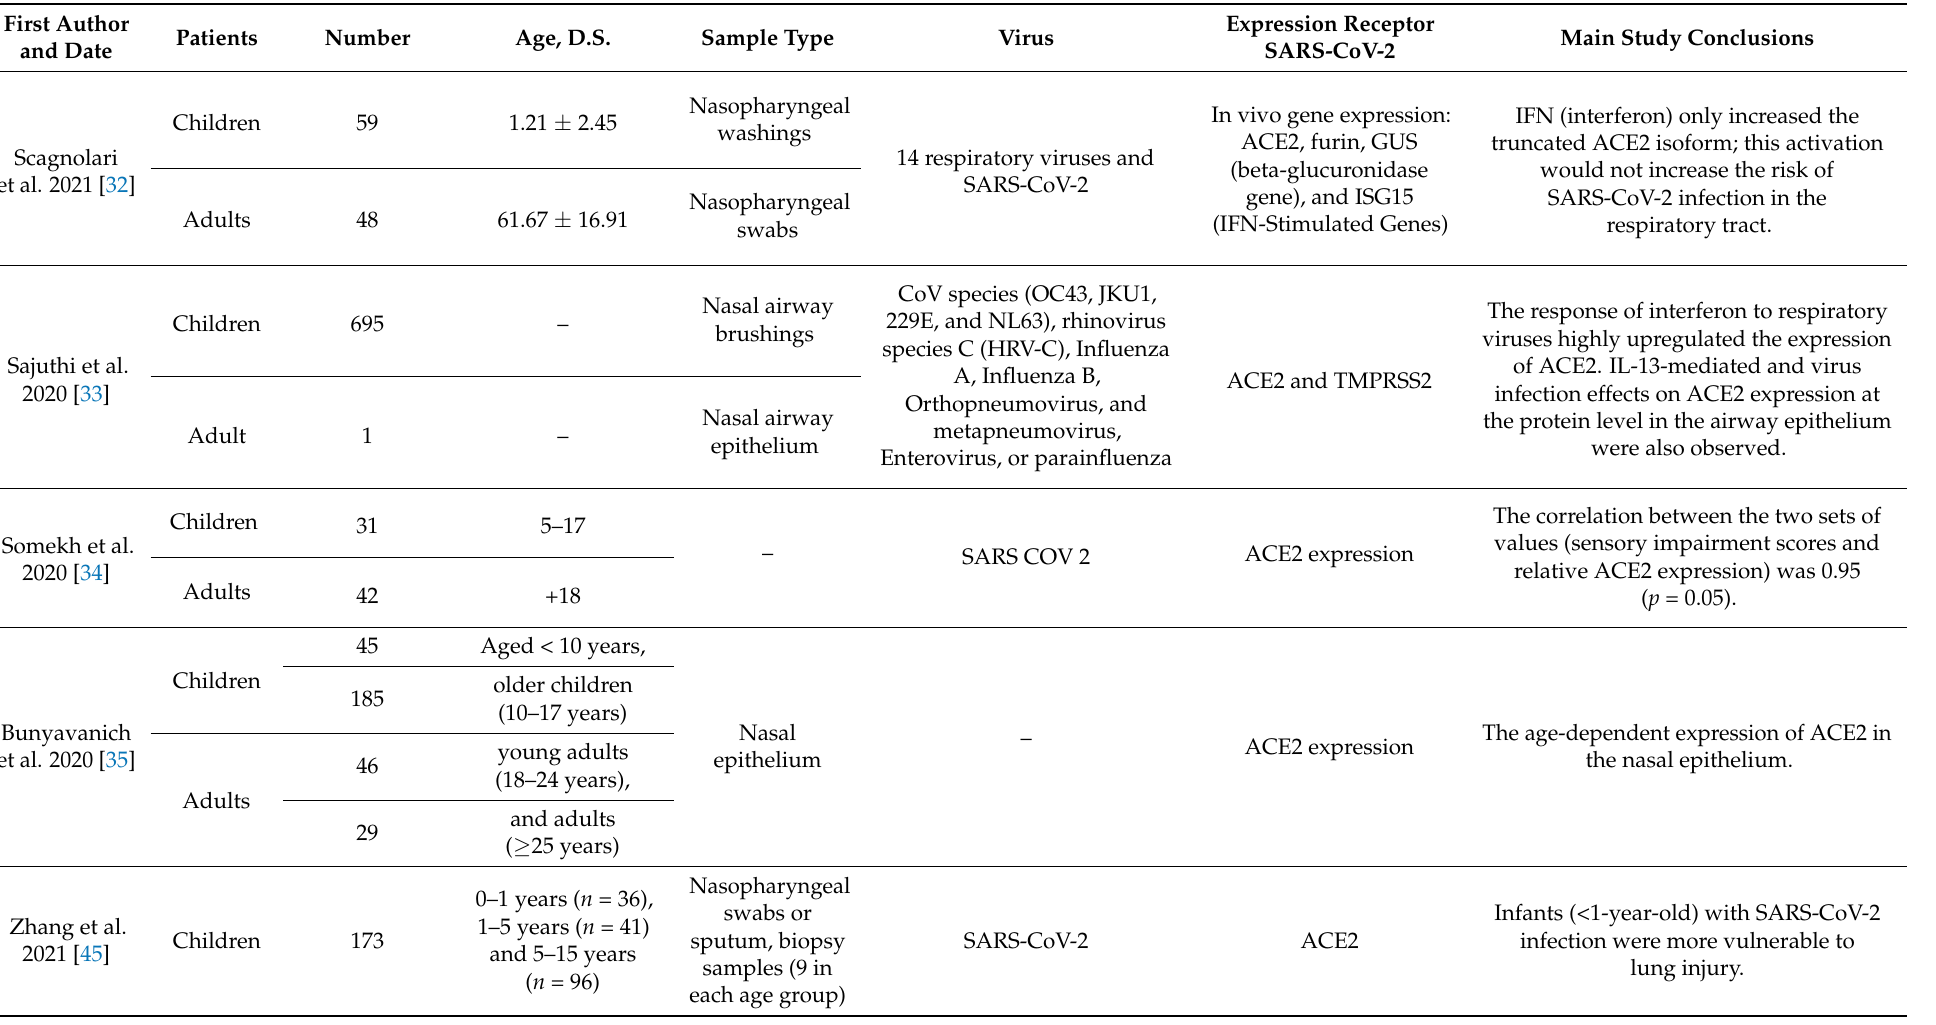
Table 3. Primary information extracted from the articles concerning the role of ACE2 expression in children related to the pathogenesis of